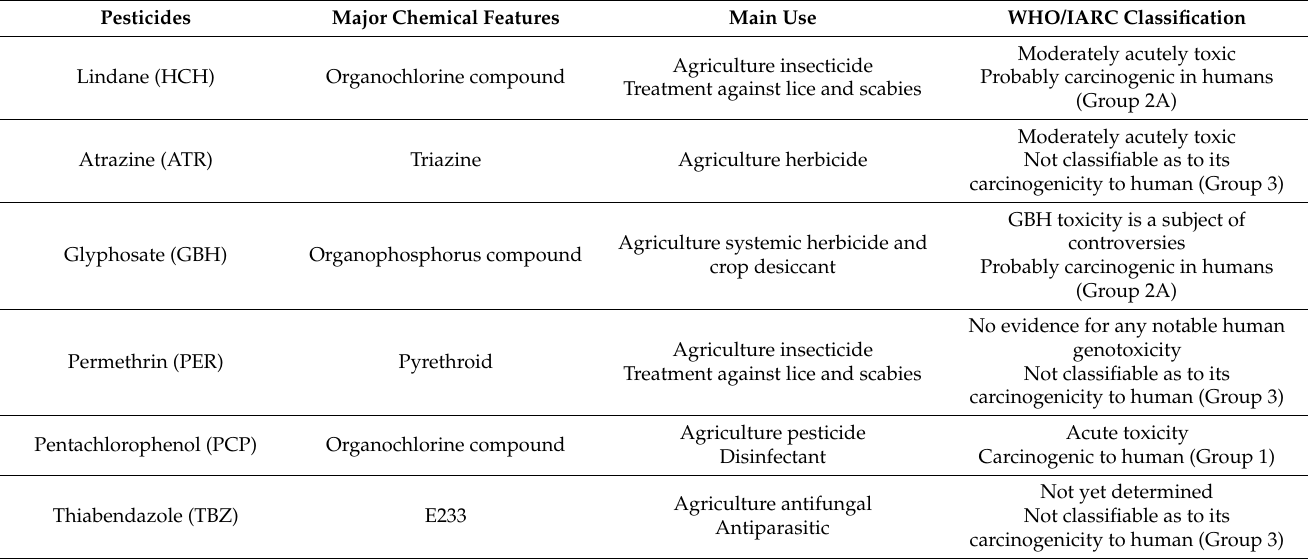
Table 1. Major features of the pesticide molecules used in this